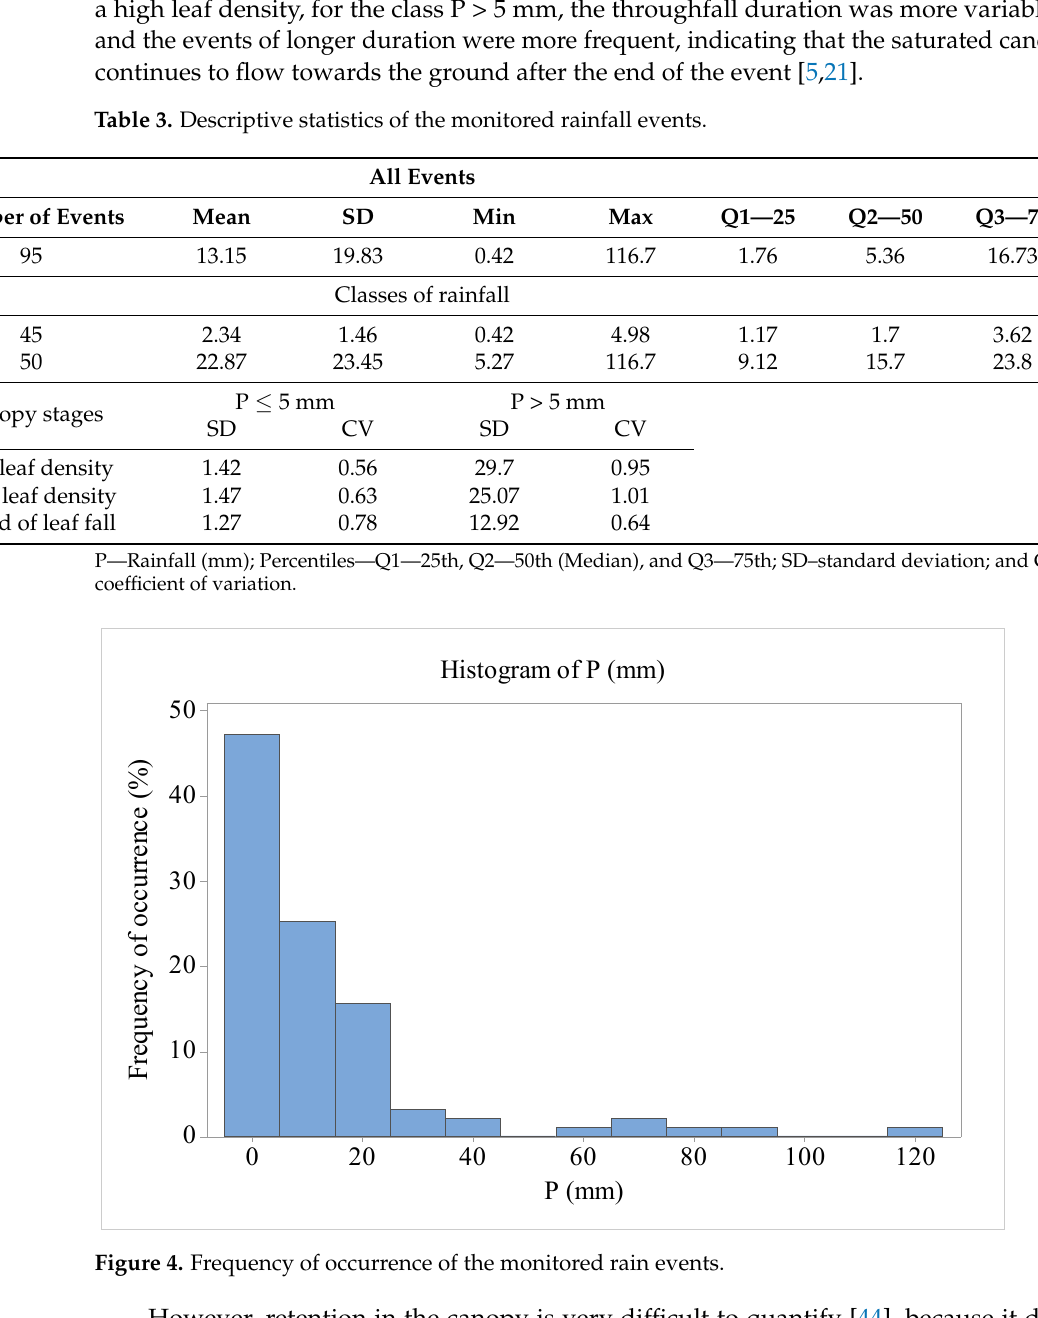
Figure 5. Relationship between gross rainfall (P) and throughfall (TF) in the three stages of canopy development: (Figures a , b ) on the top means P ≤ 5.0 mm and (Figures c , d ) on the bottom means P >